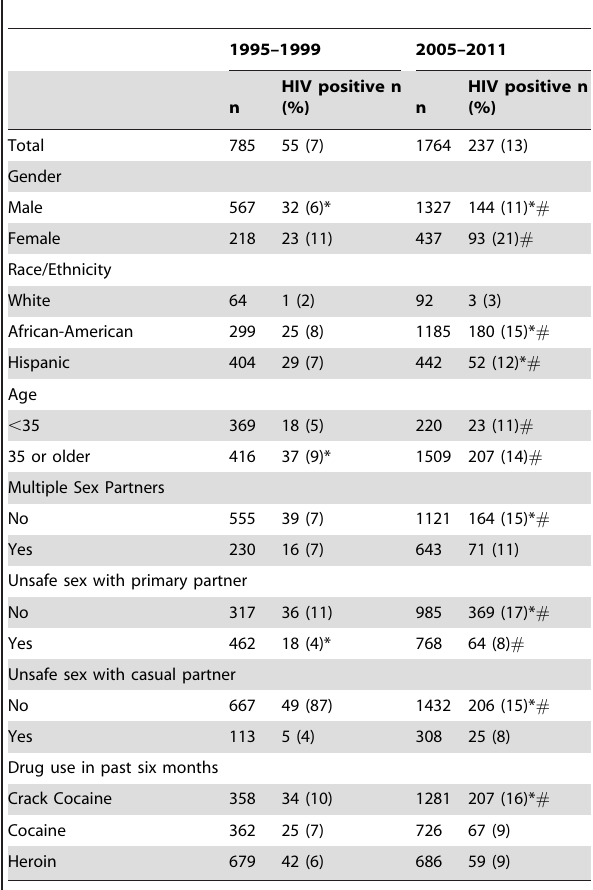
Table 2. HIV seroprevalence among never-injecting drug users, New York City, 1995–1999.